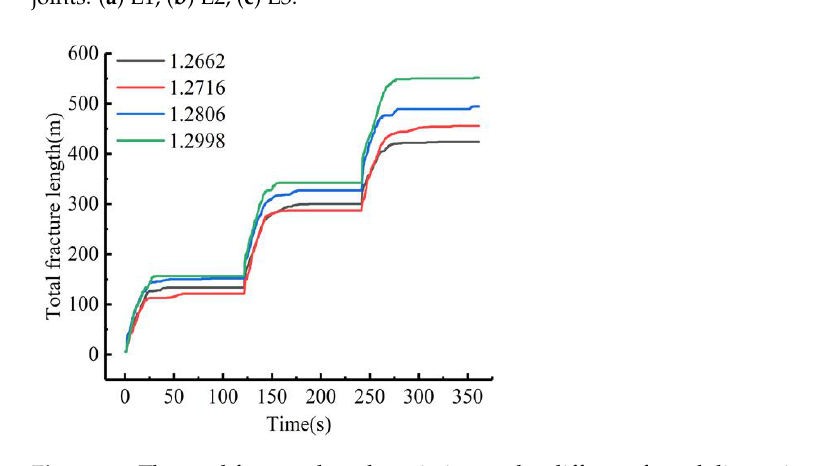
Figure 12. The total fracture length variation under different fractal dimensions of natural joints in CBM reservoirs with segmented hydraulic fractures.